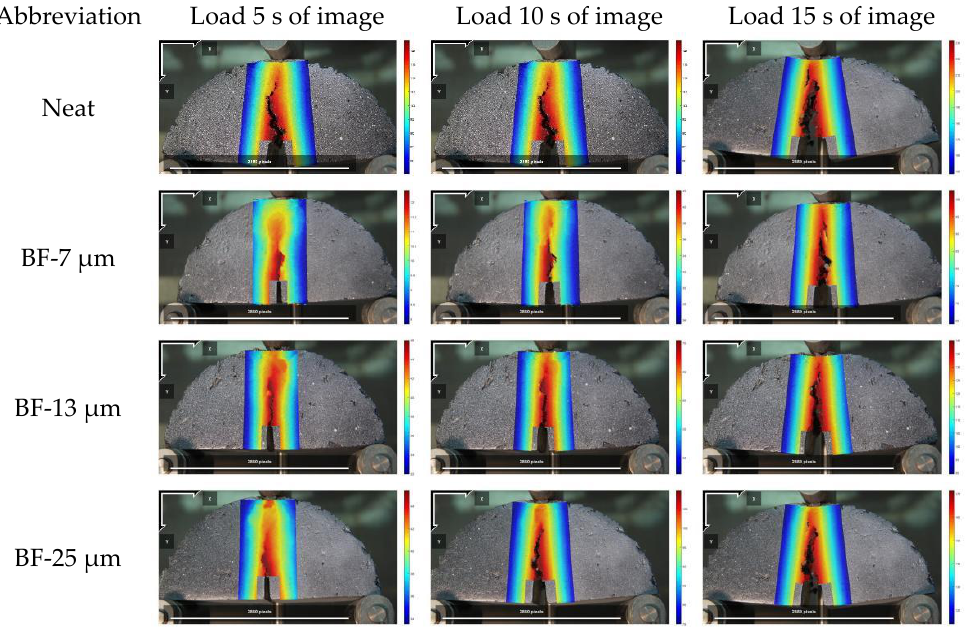
Figure 15. Vertical displacement cloud pictures.